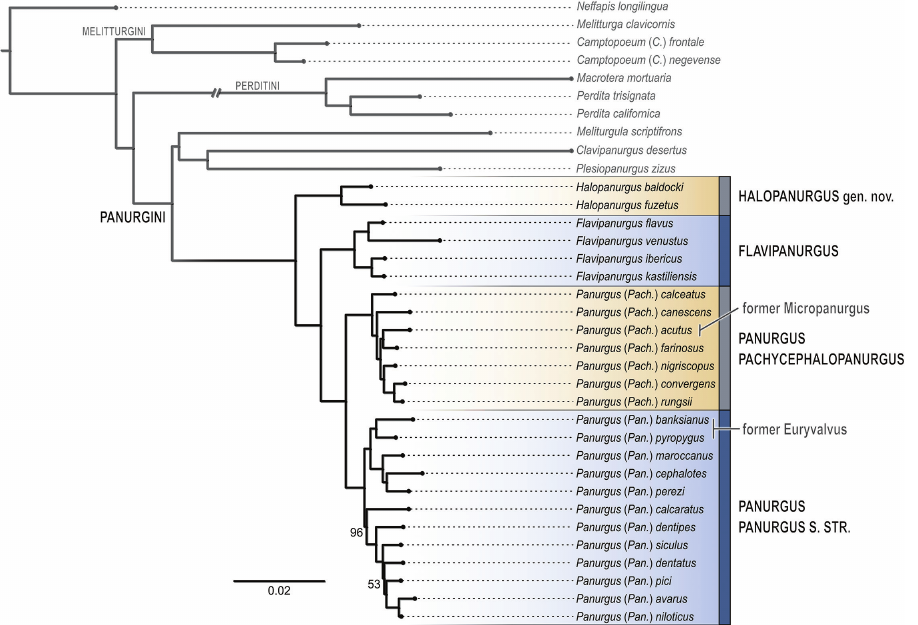
Figure 2. Maximum Likelihood phylogeny of Panurgus , Flavipanurgus , and the newly described genus Halopanurgus gen. nov., based on 2,055 ultraconserved elements. Taxonomic names reflect the nomen- clatural changes proposed in this study. Node support corresponds to 100 ultrafast bootstrap support values unless indicated